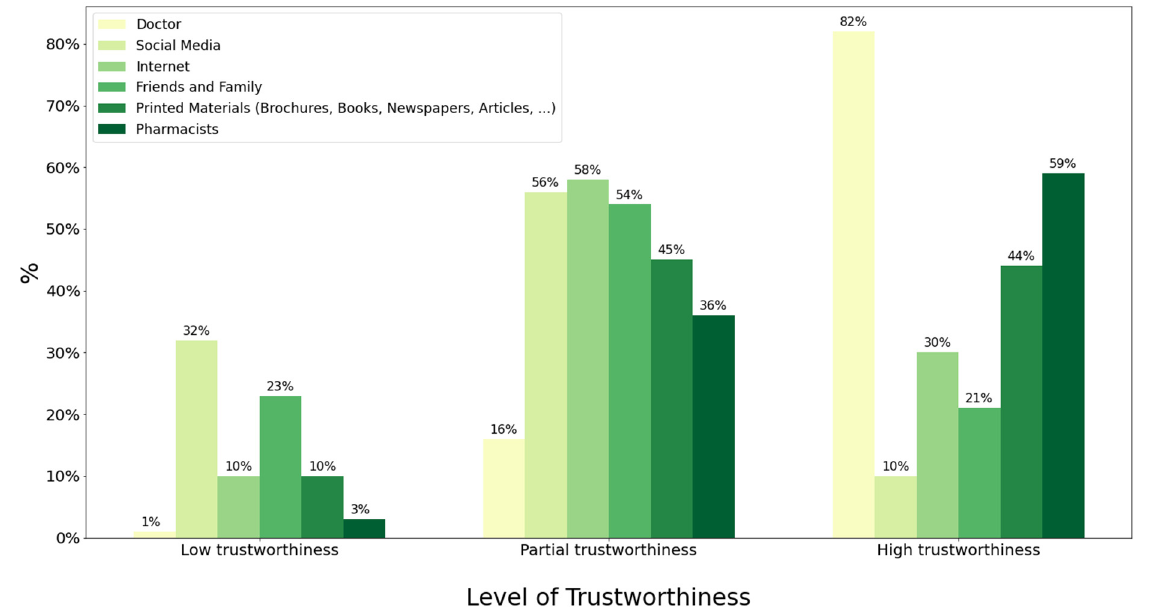
Figure 2. The level of trustworthiness for the different health information sources.